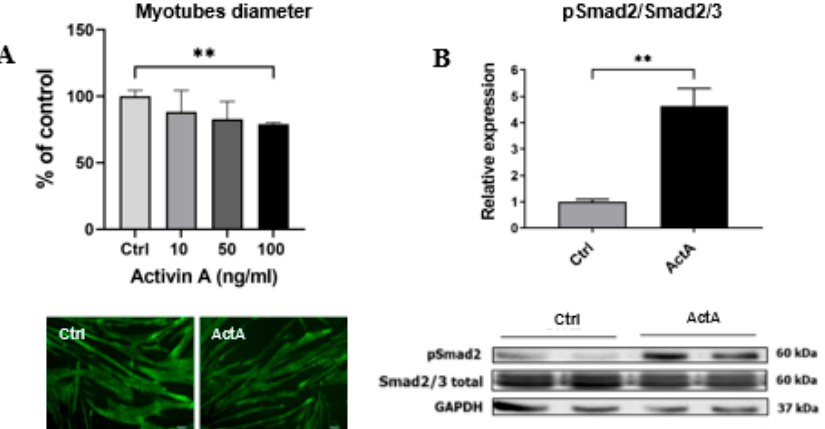
Figure 1. Activin A causes atrophy of human skeletal muscle cells. ( A ) Diameter of myotubes exposed to an increasing dose of recombinant activin A (ActA) or vehicle (Ctrl) for 48 h. Data are expressed as a percentage of the values for the control. ( B ) pSmad2/Smad2/3 ratio measured by western blot, in cells collected 1 h after exposure to recombinant ActA (100 ng/mL) or vehicle. Data are reported as means ± SEM (n = 3/condition). ** p < 0.01 vs. Ctrl.